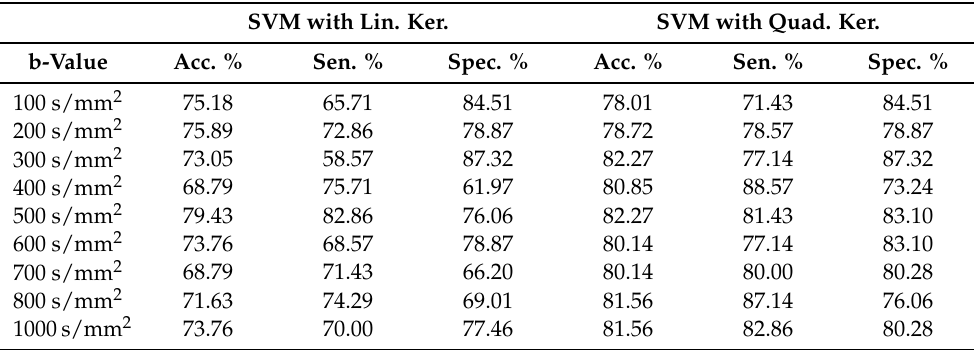
Table 9. Performance of SVMs with linear kernel (lin. ker.) and quadratic kernel (quad. ker.) at 9 b-values using 141 randomly chosen ADC maps, where Acc. means accuracy, Sen. means sensitivity, and Spec. means specificity.